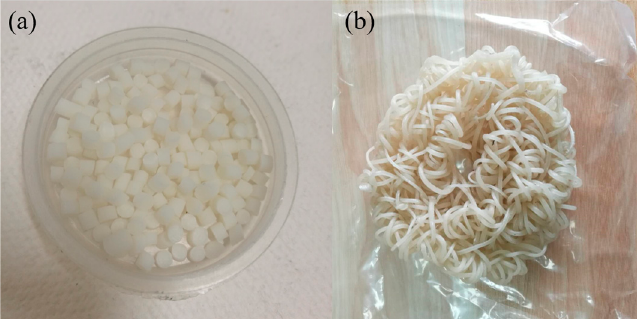
Table 2. The formulation and abbreviation of the samples.